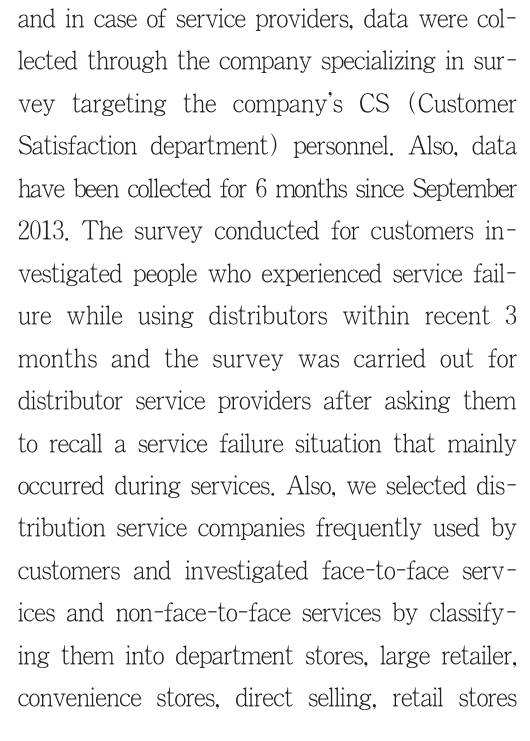
<Table 5> Characteristics of the